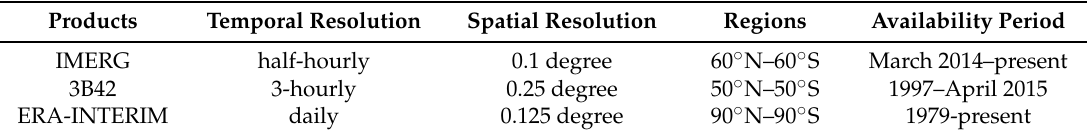
Table 1. Characteristics of Satellite/Model Precipitation